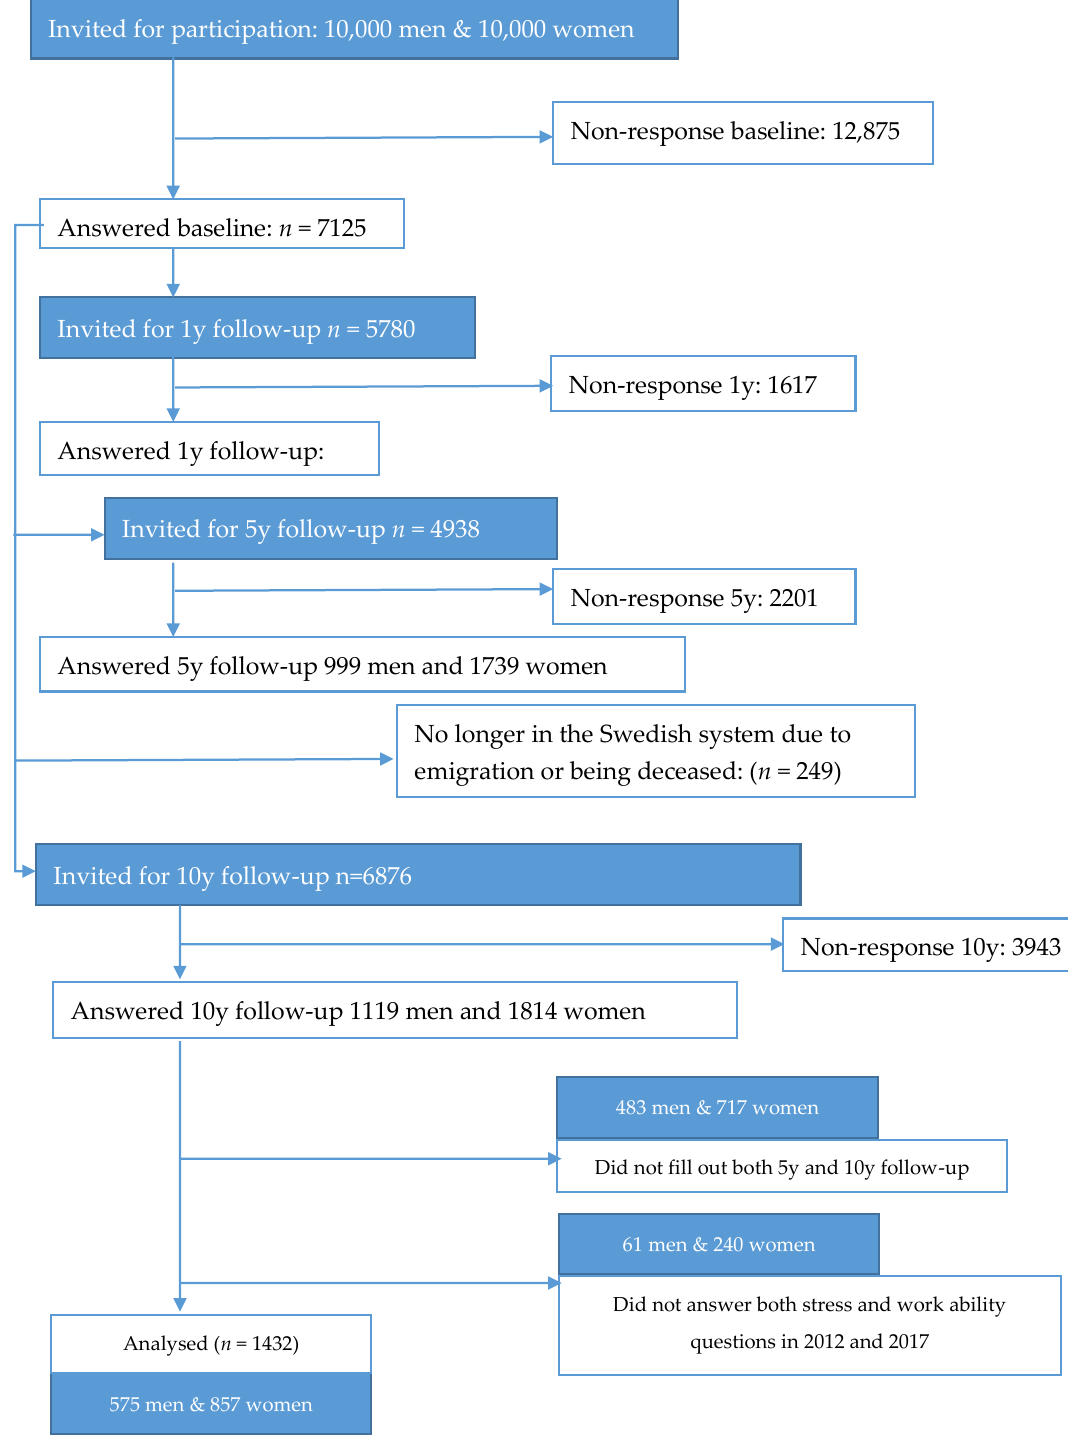
Figure C1: Flowchart of inclusion of the Work Ability in Young Adults (WAYA) cohort. Figure A4. Flowchart of inclusion of the Work Ability in Young Adults (WAYA)